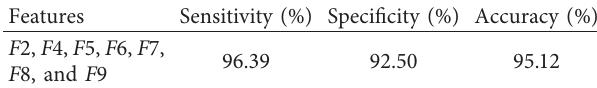
Table 5: Classification results using data from first 128 cycles. Features